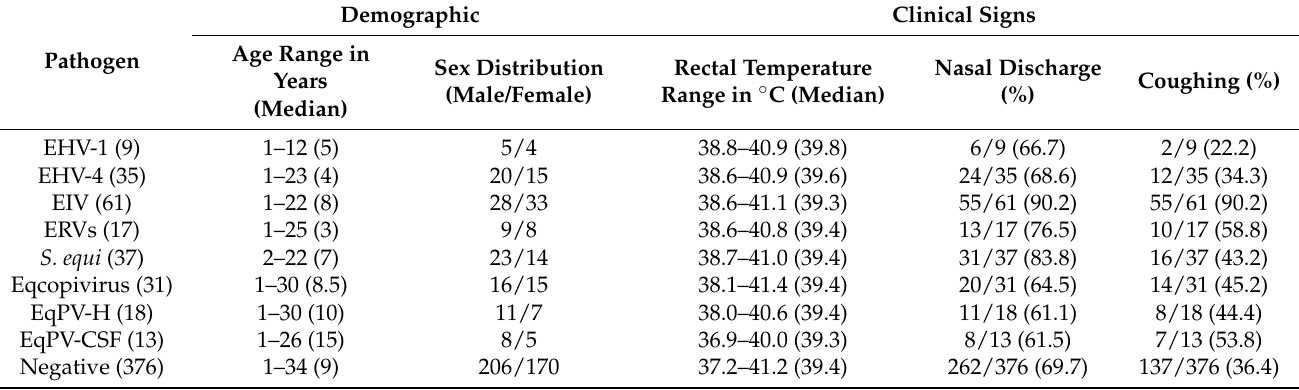
Table 3. Demographic and clinical data from 667 equids with acute onset of fever and/or respiratory signs. The data is presented for each common respiratory pathogen and the three newly identified equine parvoviruses. Only animals with a single detected pathogen are reported. Demographic and clinical information was available for approximately 68% of the sick